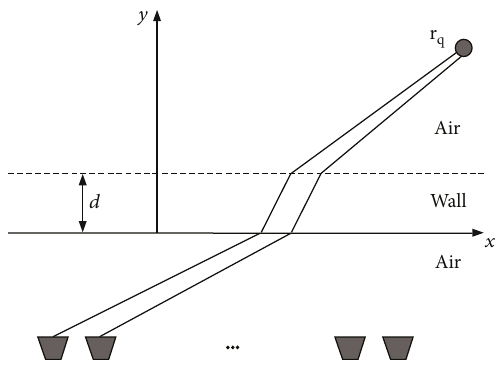
Figure 1: 2-D geometry of the polarimetric TWRI